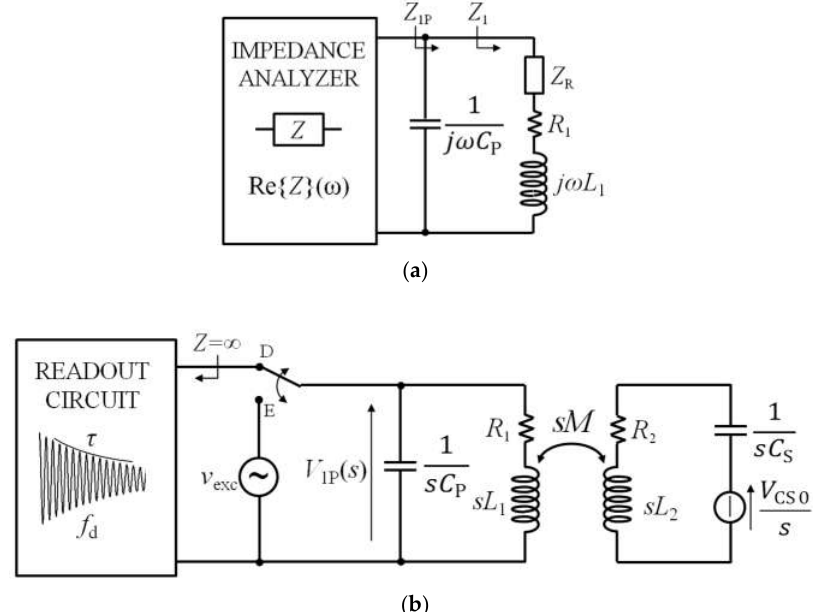
Figure 10. ( a ) Block diagram of the interrogation system with equivalent circuit of the impedance Z 1P for the technique based on impedance measurements applied to a coil-coupled capacitance sensor; ( b ) block diagram of the interrogation system with equivalent circuit in the Laplace domain to derive V P1 ( s ) during the detection phase of the time-gated technique applied to a coil-coupled capacitance sensor.